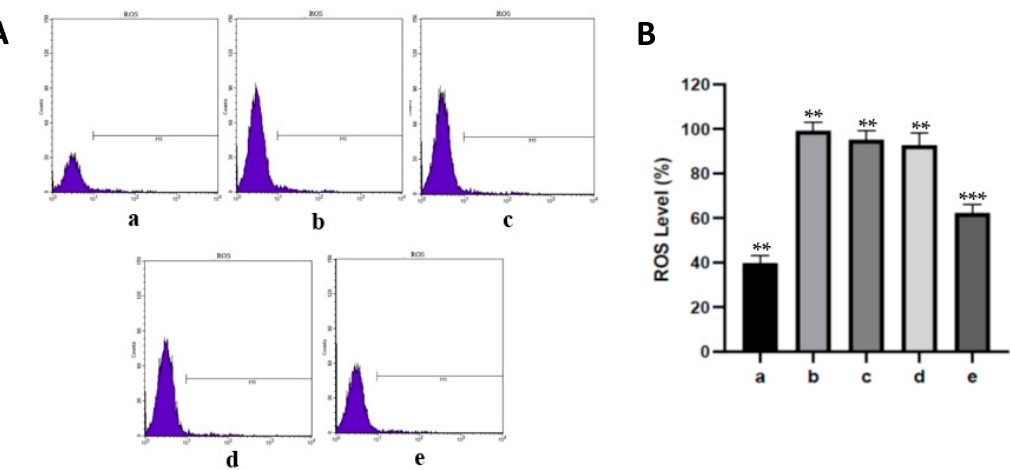
Figure 2. ( A ). Flow cytometry assay using DCFH-DA dye on fucoidan nanoparticles to assess effect on preventing oxidative stress. ( B ). The level of ROS in aortic endothelial cells was analyzed by flow cytometry. Control rats ( a ); diabetic rats ( b ); fucoidan nanoparticle rats, at doses of 75 ( c ), 150 ( d ), and 300 mg/kg BW ( e ). ** - ***The columns with different letters show significance between groups ( p < 0.05).